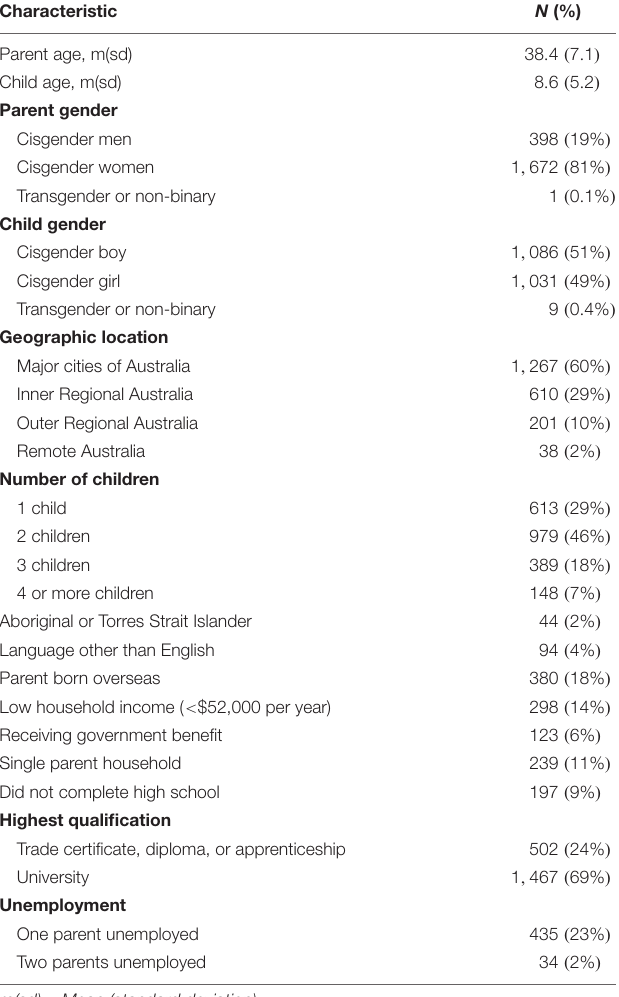
TABLE 1 | Sample characteristics for the analysis sample of the COVID-19 Pandemic Adjustment Survey (CPAS) ( N =